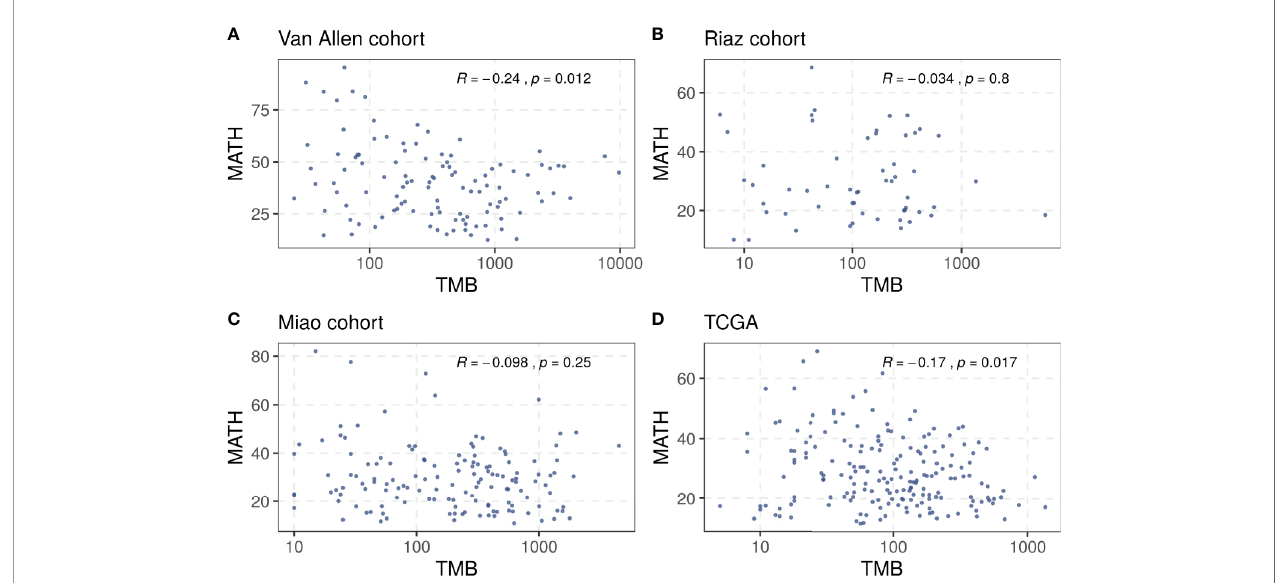
score with the clonal TMB based on the clonal results collected from the included studies and the correlation result is shown in Figure 2 . We found that the bene fi t score correlated positively with the clonal TMB in the Riaz cohort (R = 0.59, p = 0.0051) and the Miao cohort (R = 0.96, p < 0.001). A similar trend was observed in the TCGA melanoma dataset (R = 0.94, p < 0.001). The diversity in the signi fi cance of the correlation between the Riaz cohort and the other two cohorts might have been caused by the number of patients and approach used to estimate clonality.